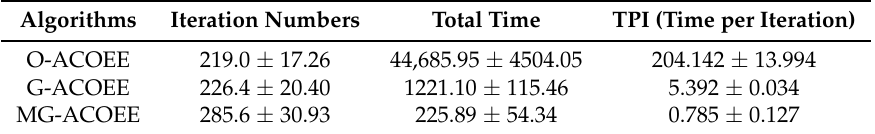
Table 9. Comparison of O-ACOEE, G-ACOEE, and MG-ACOEE (full constraint) on computing performance for Urban data.